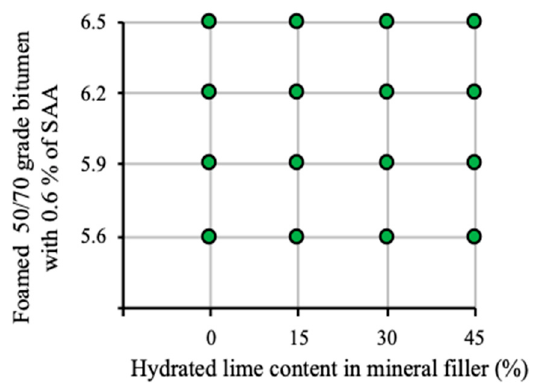
Figure 3. Experimental design [72].